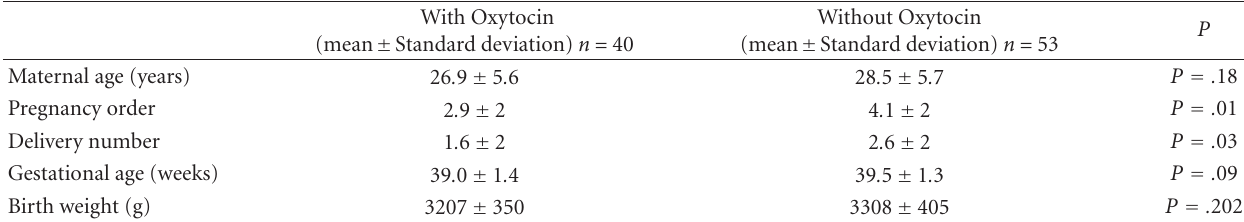
Table 1: Demographic characteristics.